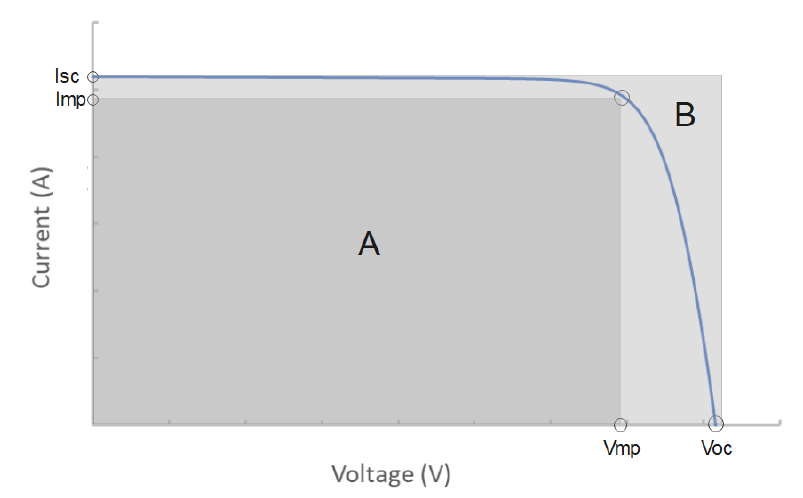
Figure 1. Ideal shape of solar cell I-V characteristic curve. The open-circuit voltage represents the voltage between the terminals of the PV cell/module without any load connected to it (open circuit condition in the PV device’s terminals). At this voltage, there is no output current. The short-circuit current represents the current flowing through the short-circuited terminals when the voltage at the terminals is zero. The maximum power current and voltage represent the current and voltage levels that provide the highest power output as can be seen in Figure 2.